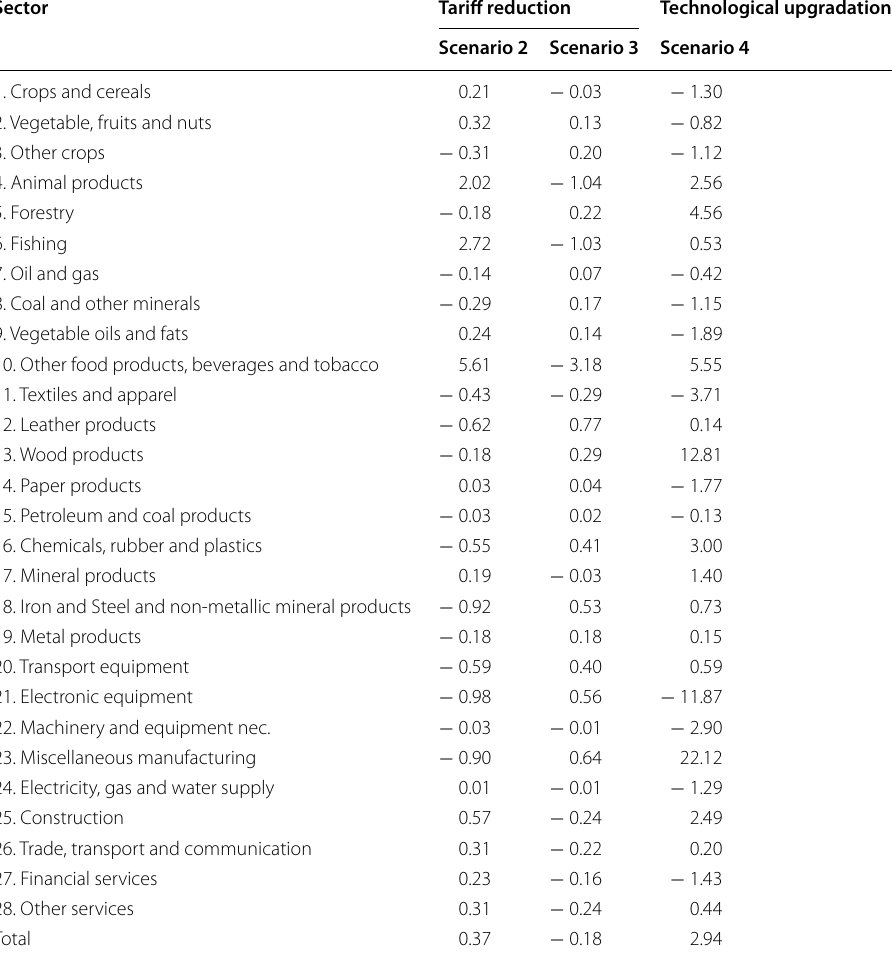
Table 3 Sectoral output growth due to tariff simulation and technological upgradation at 2030 compared to BAU 2030 (without USA as TPP